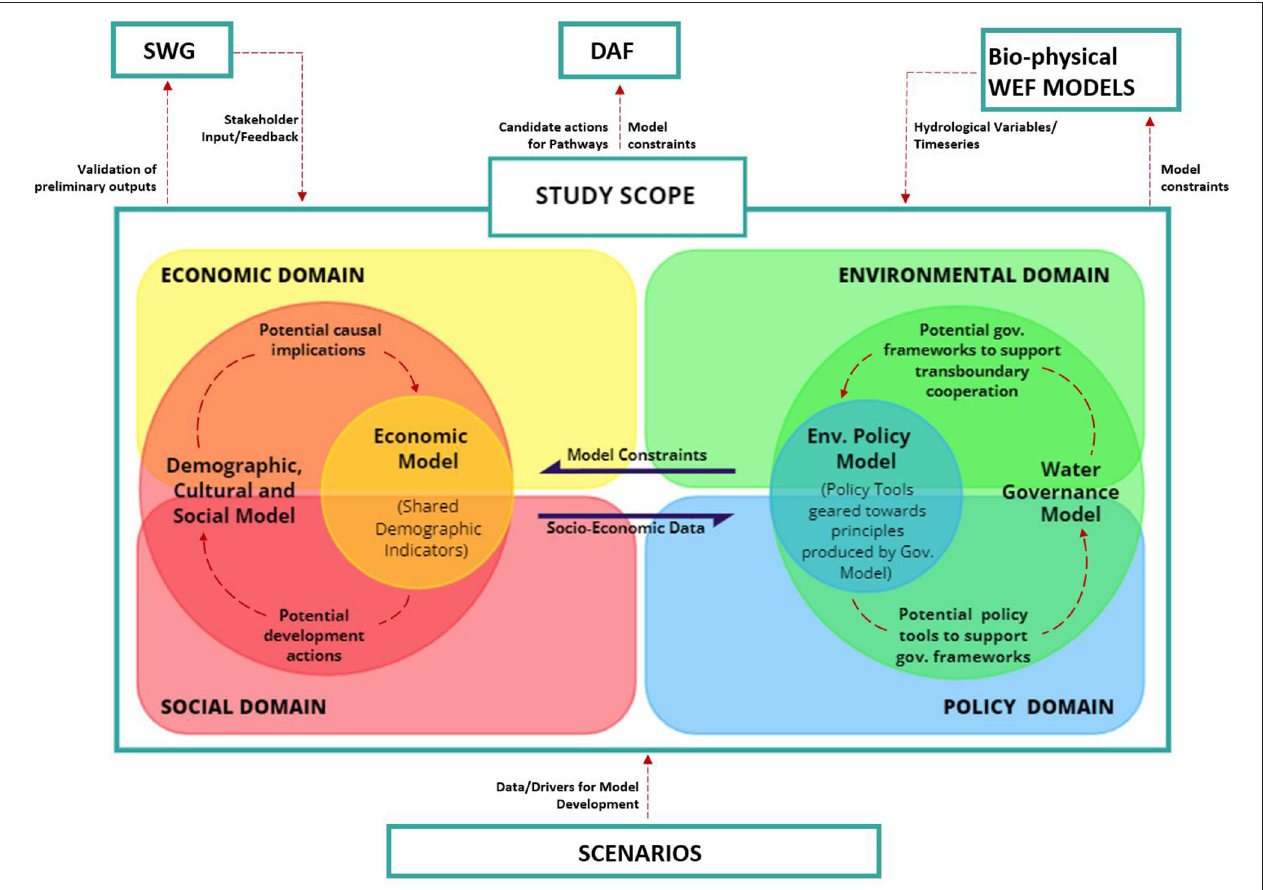
FIGURE 3 | Conceptual integration of socio-anthropologic models with bio-physical models under the WEF nexus